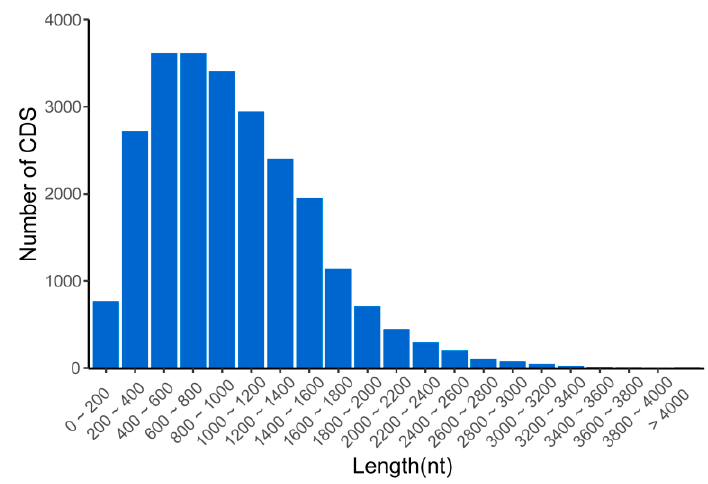
Forests 2020 , 11 , x FOR PEER REVIEW Figure 4. The length distribution of coding sequences (CDSs). Figure 4. The length distribution of coding sequences (CDSs).